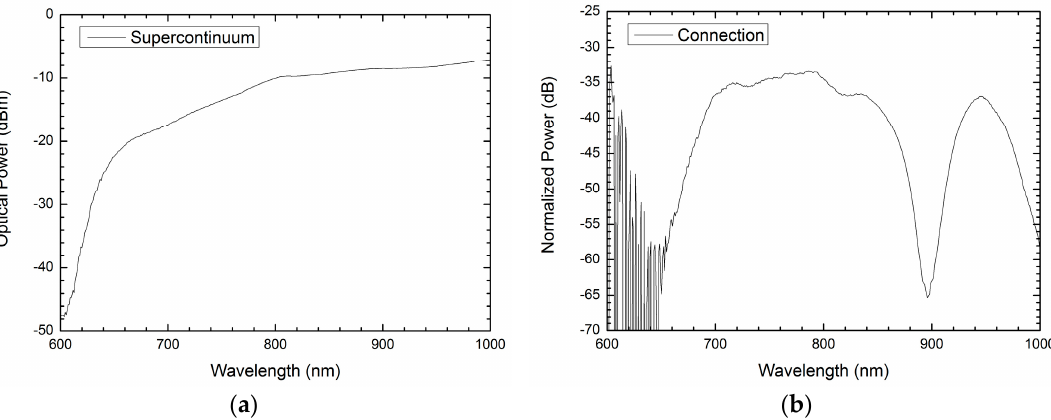
Figure 5. ( a ) Supercontinuum source spectrum and ( b ) normalized transmission spectrum using the fiber taper tip connection.